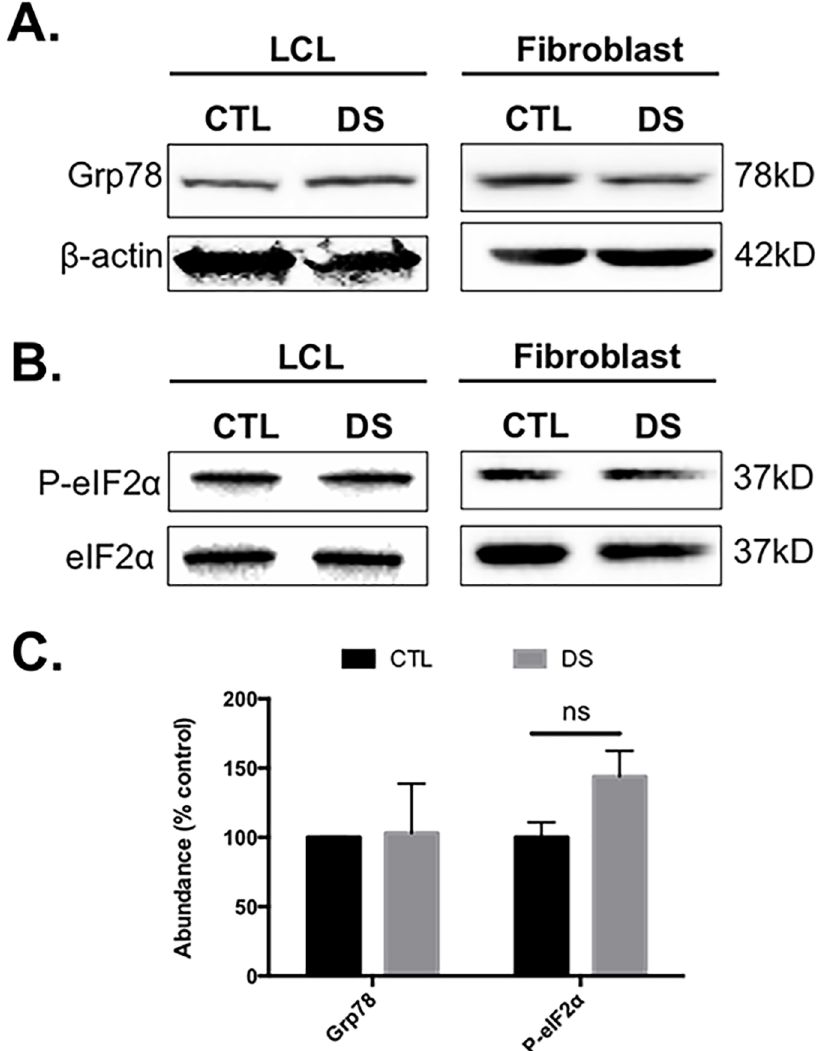
Fig 3. Grp78 and the PERK-eIF2 α pathway are not basally up-regulated in DS LCLs or fibroblasts. Western blot analysesin both LCLs and fibroblasts from DS and euploidcontrols did not show a difference in either basal Grp78 abundance (A) or abundance and phosphorylation status of eIF2 α